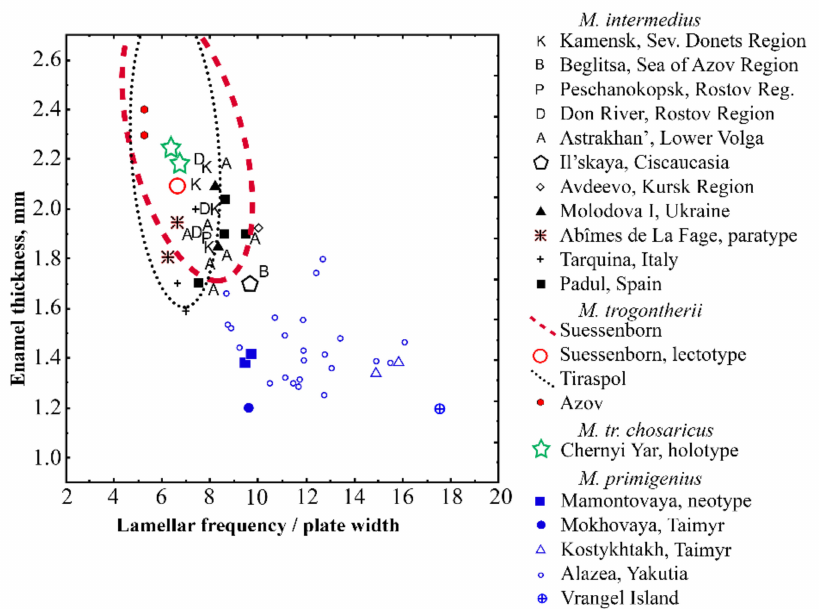
Figure 11. Ratio of the lamellar frequency/plate width quotient and enamel thickness on the upper M3 of Mammuthus intermedius from the Lower Don Region compared to the other representatives of the genus Mammuthus